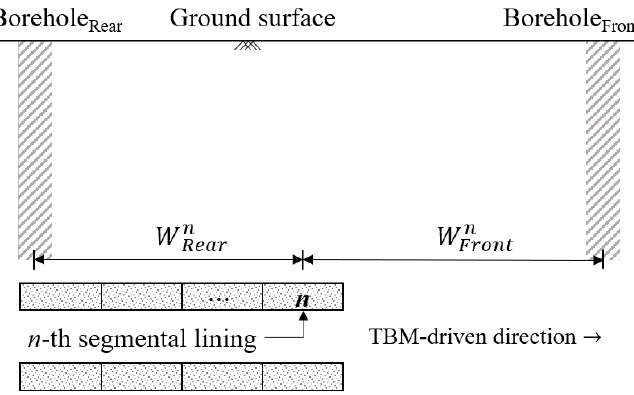
Figure 3. n -th weight parameters corresponding to n -th segmental lining. Table 3. Input parameters for predicting the current value of thrust.